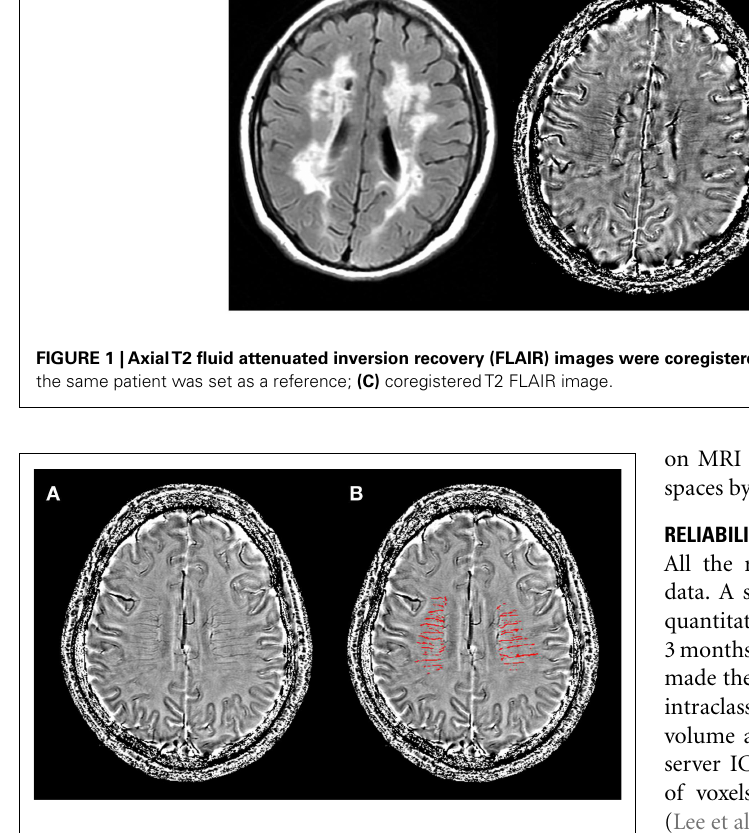
FIGURE 2 | Image post-processing and segmentation of the deep medullary venous structures were based on filtered phase images . (A) A filtered phase slice of oneWMH patient; (B) the same slice after segmentation used to calculate the number of voxels of the deep medullary veins for